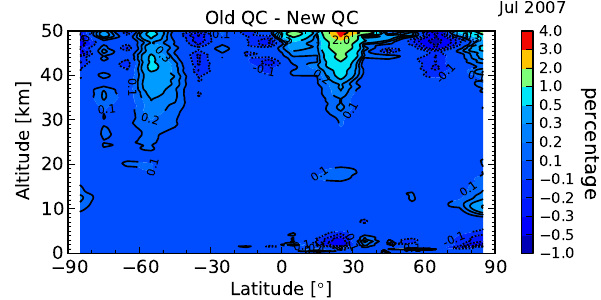
Fig. 3 : Relative difference between monthly mean refractivities obtained by average-profile Figure 3. Relative difference between monthly mean refractivities inversion with standard quality control (Old QC) and additional quality control (New QC), for obtained by average-profile inversion with standard quality control CHAMP data from July 2007. (old QC) and additional quality control (new QC) for CHAMP data from July 2007.